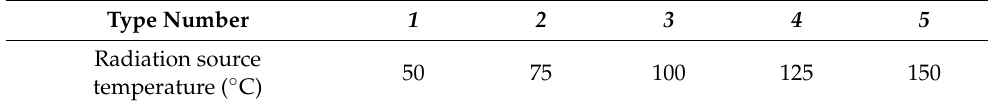
Figure 3. Image of the coating plate, reference body, and black background plate. Five irradiation energies (denoted by the temperature of the radiation source) were selected, as displayed in Table 2. Table 2. Irradiation energy and type number.